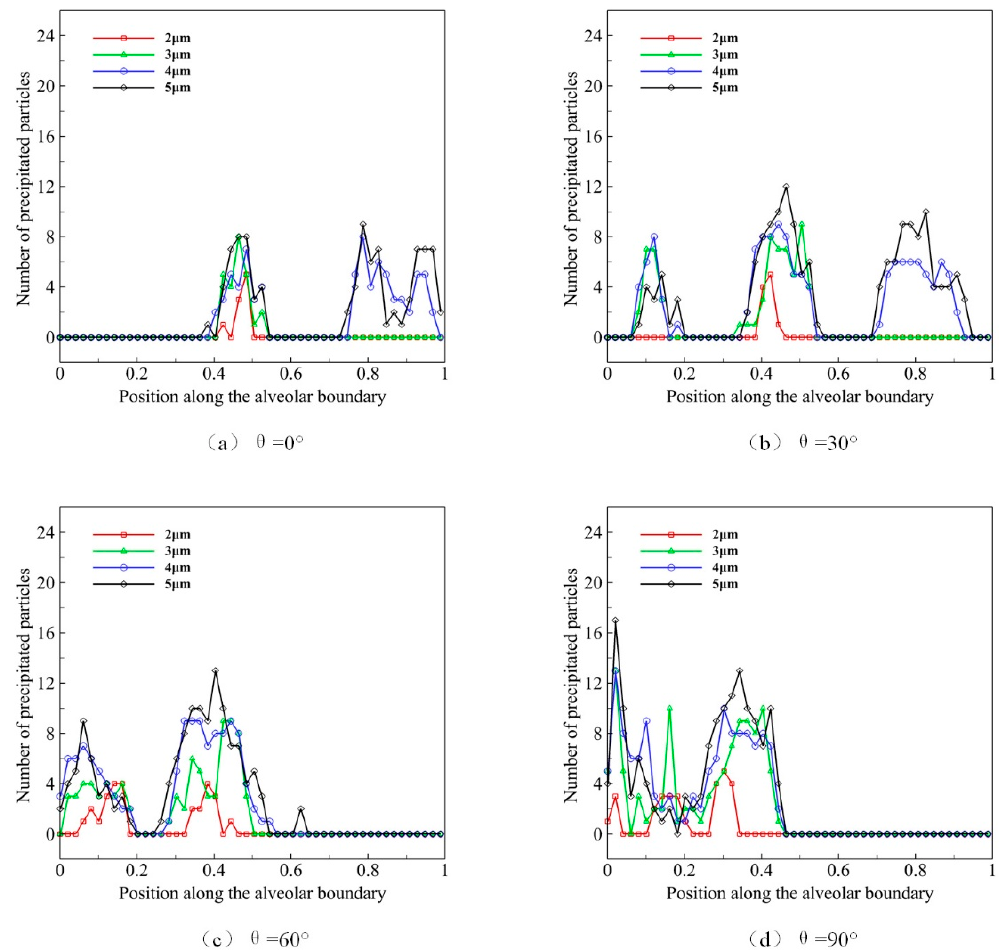
Figure 9. The deposition and distribution of microparticles in pulmonary acini at different microparticle diameters.